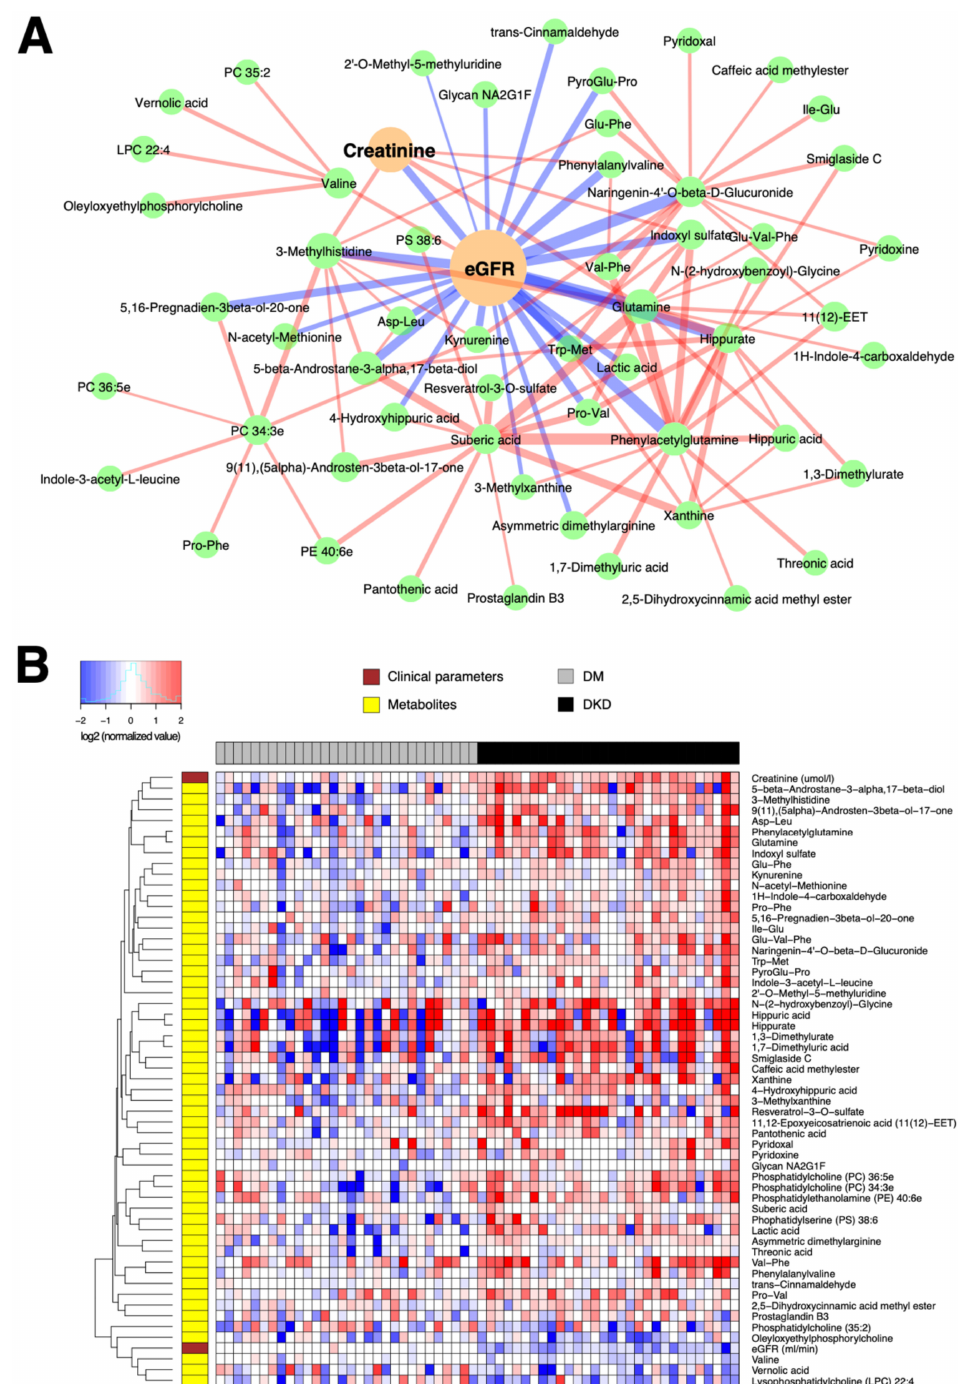
Figure 4. ( A ) Subnetwork signature distinguishing 30 DKD patients from 30 DM-N patients. Network edges are drawn in different colors depending on the sign of the partial correlations (positive in red, negative in blue); thicker edges represent stronger relationships. The size of the nodes corresponds to their respective − log10(q-value) from univariate differential abundance tests (two-sample t -test). ( B ) To demonstrate the abundance patterns more clearly, heatmap of relative abundance values of individual compounds was drawn (log-transformed, base 2), normalized by the median of DM-N, in which the plasma levels of a majority of compounds were elevated in DKD